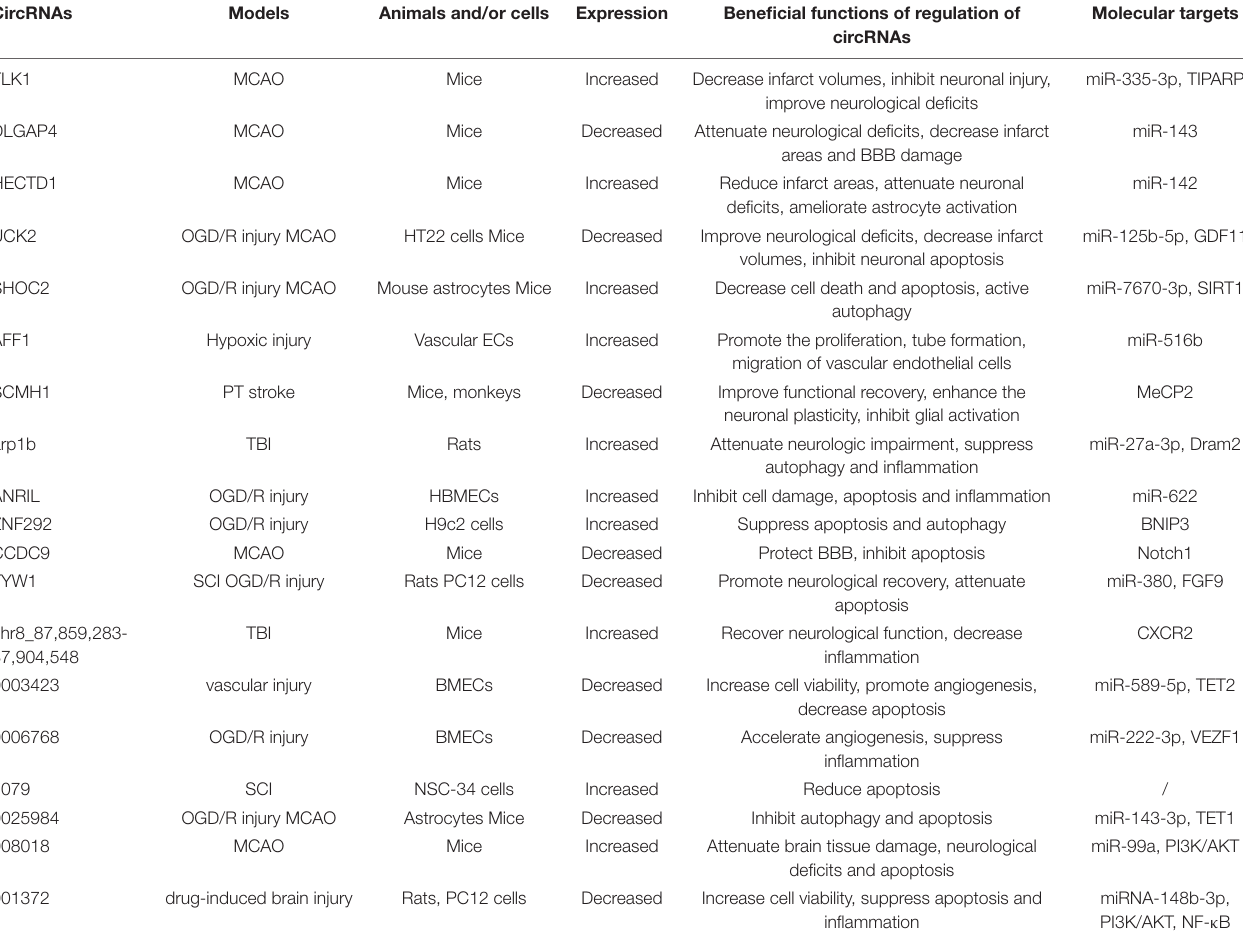
TABLE 2 | The functions and molecular targets of circRNAs in acute CNS injury models.